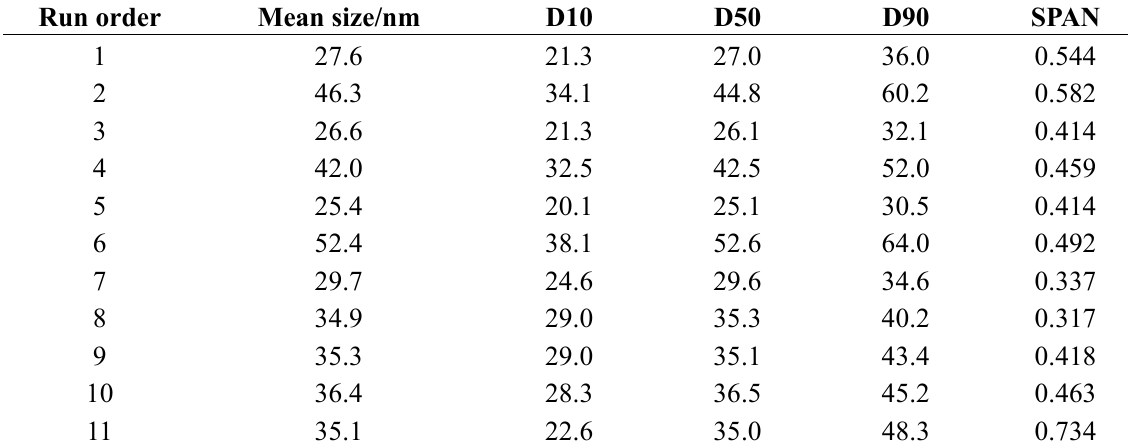
Table 1. Mean size and particle size distribution of PVM/MA particles prepared by supercritical CO 2